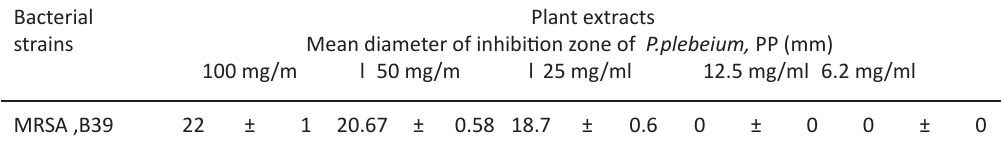
Table 2a. Determination of (MIC) of the plant extracts of P. plebeium , PP against MRSA. B39 Bacterial